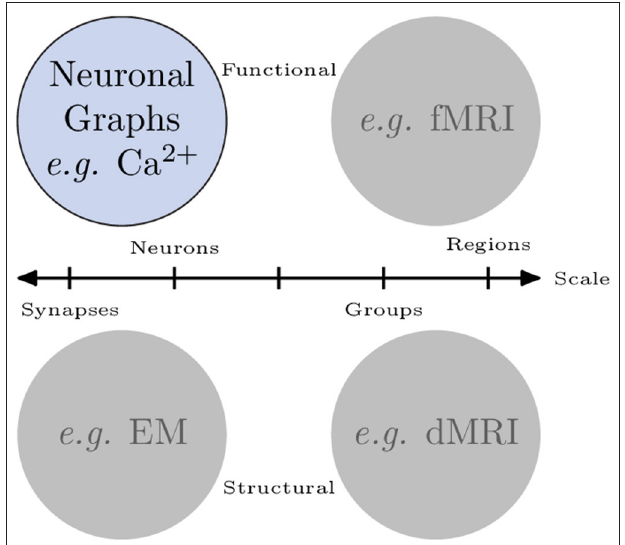
FIGURE 1 | Networks of neurons occur across scales and can be functional or structural. Microscopic networks (left) , i.e., at neuron or synapse scale, are usually recorded with calcium imaging or electron microscopy techniques. Macroscopic networks (right) , i.e., recordings of indistinguishable groups of neurons or brain regions, are often recorded using MRI techniques. Neuronal Graphs are microscopic (neuron-resolved), functional networks extracted from calcium imaging